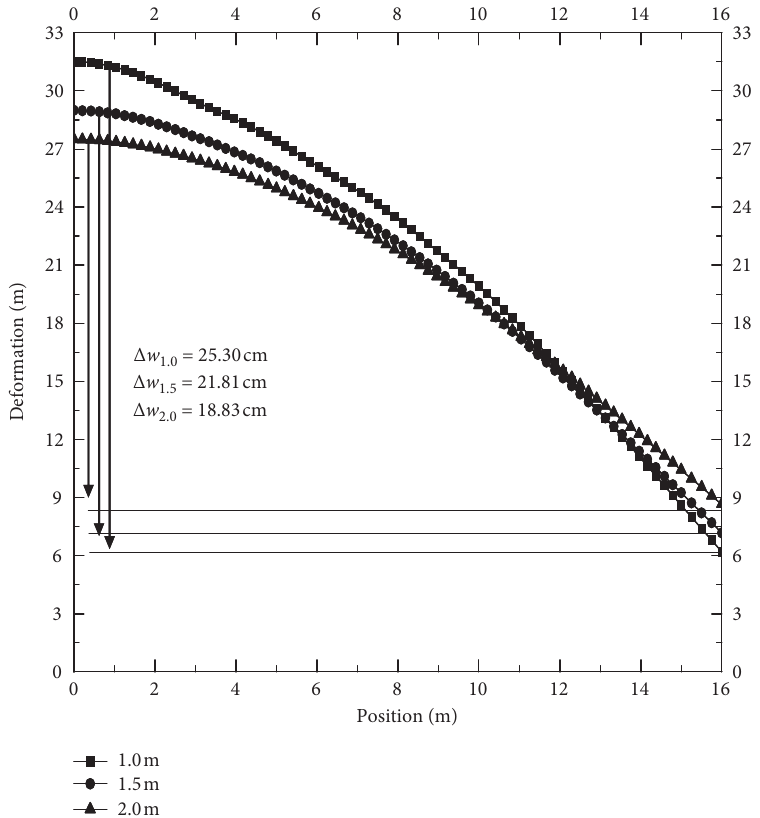
Figure 11: Deformation versus time with different thicknesses of